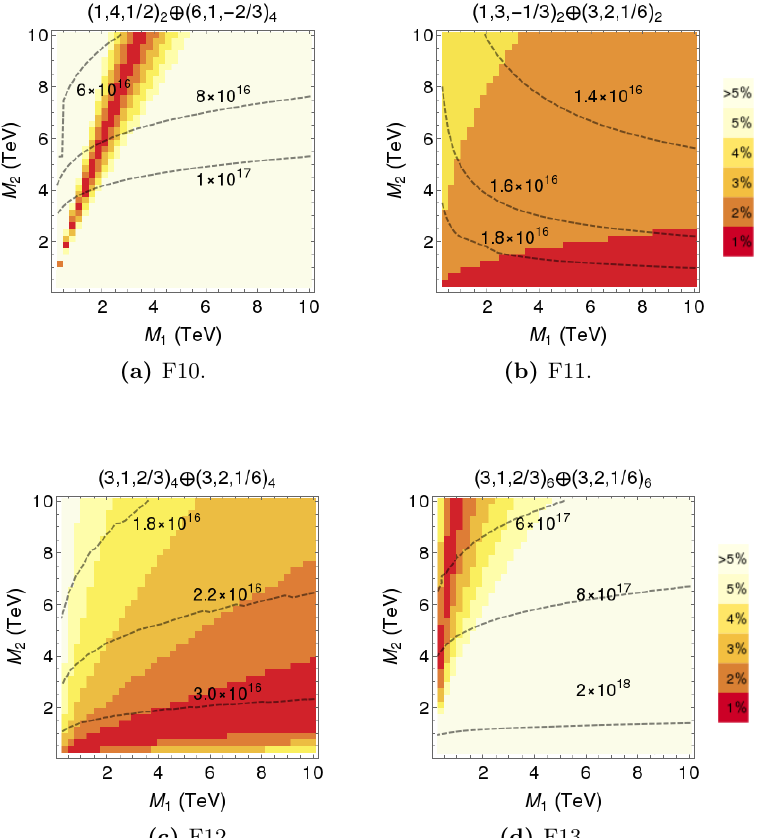
Figure 2. Distribution of the mismatch parameter (cid:15) GUT as a function of M 1 and M 2 for the scenarios F10{F13 of table 3. Red area corresponds to the PGU ( (cid:15) GUT (cid:20) 1%). Di(cid:11)erent shades of yellow illustrate departure from the precise uni(cid:12)cation condition as quanti(cid:12)ed by the increasing values of (cid:15) GUT . Isocontours of the uni(cid:12)cation scale (in GeV) are indicated as dashed black